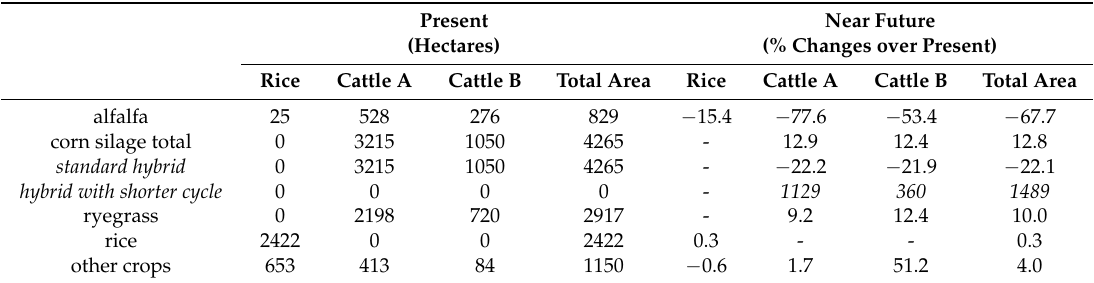
Table 3. Land use changes for the baseline and near future scenarios, absolute values (hectares), and percentage changes